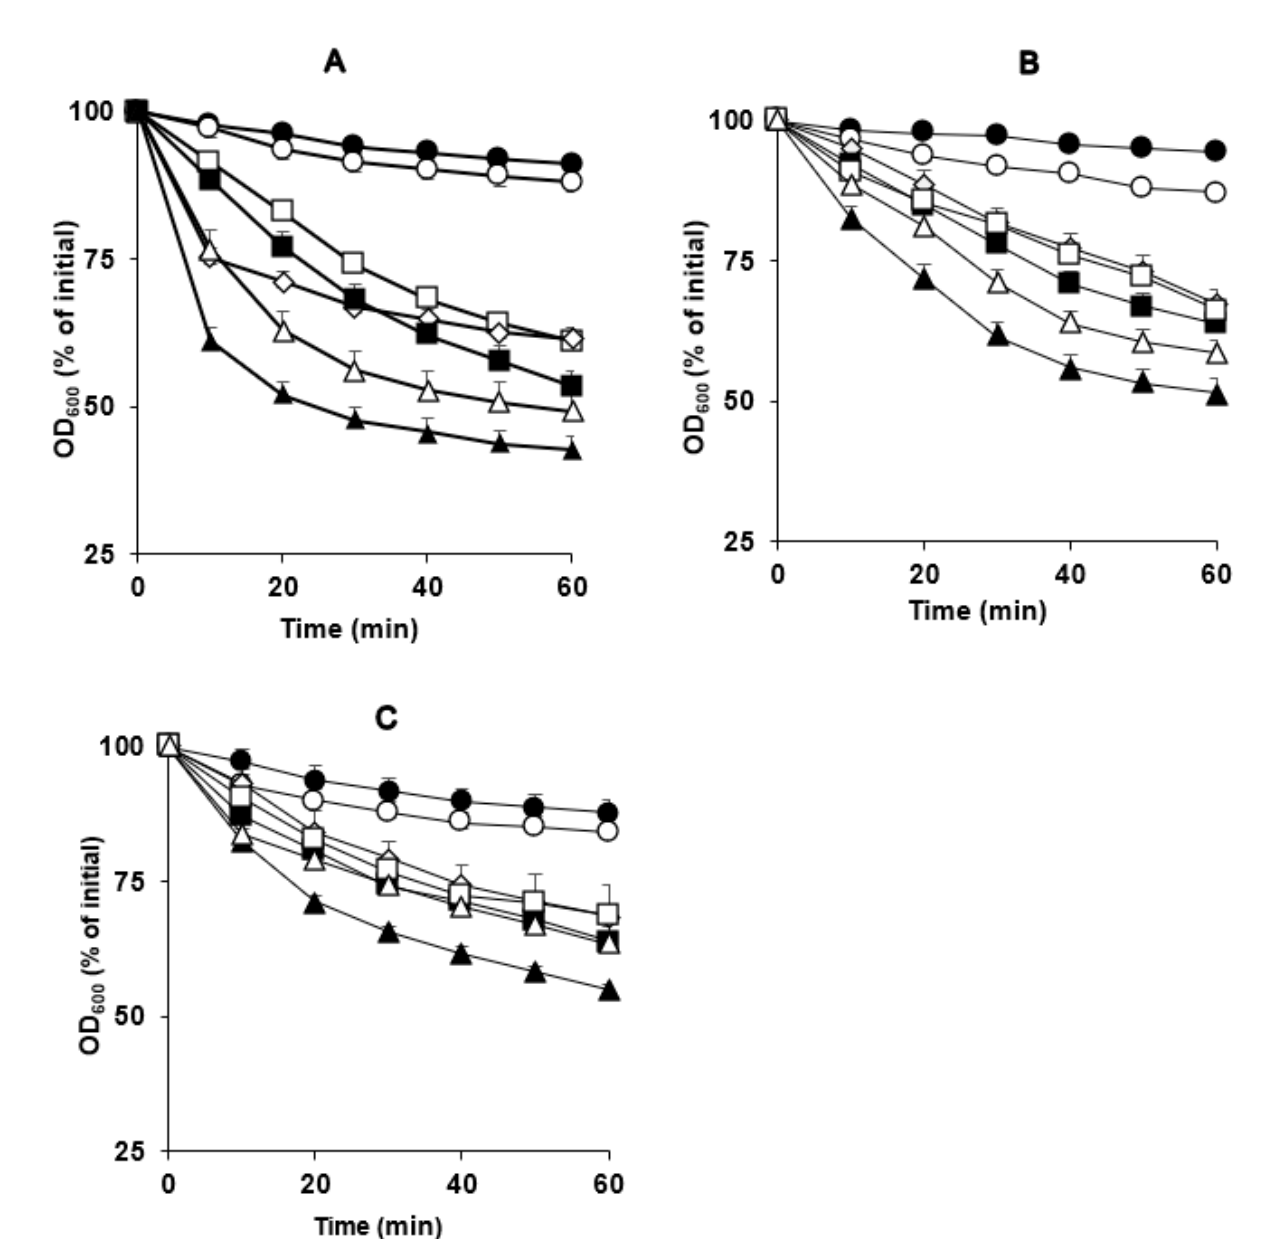
Figure 2. Spore germination of C. perfringens strains ( A ) SM101, ( B ) NCTC 10239, and ( C ) NCTC 8239 in the presence of DPA and various Ca 2+ sources . Heat-activated spores of strains SM101, NCTC 10239, and NCTC 8239 were germinated at 37 °C with 100 mM KCl (pH 6.0) (filled triangles), 50 mM CaCl 2 (pH 6.0) (open triangles), 50 mM Ca(NO 3 ) 2 (pH 6.0) (filled squares), 50 mM C 6 H 10 CaO 6 (pH 6.0) (open squares), 50 mM Ca-DPA (pH 8.0) (open diamonds), 50 mM DPA (pH 6.0) (open circles), and 25 mM Tris-HCl (pH 6.0) (filled circles). At each time point, the OD 600 was measured as described in Section 2.3 and sed to calculate percent germination. Error bars are the standard deviations from the means of at least duplicate experiments with three independent spore preparations. Note that filled squares, open squares, and open diamonds overlap in panel B and open triangles, filled squares, open squares, and open diamonds overlap in panel C.